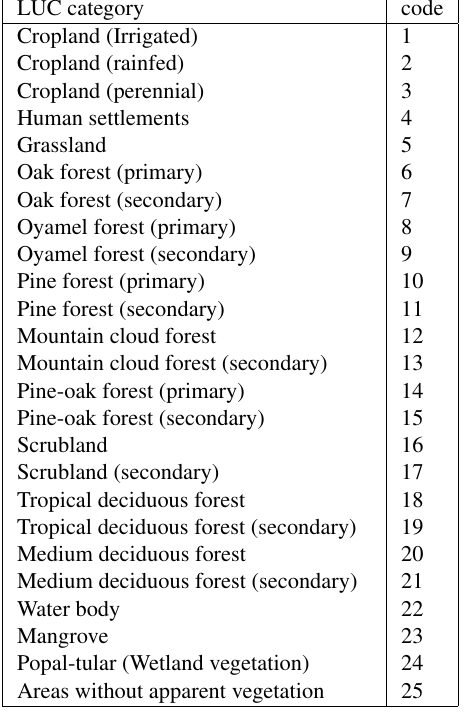
Table 1: Classification scheme.